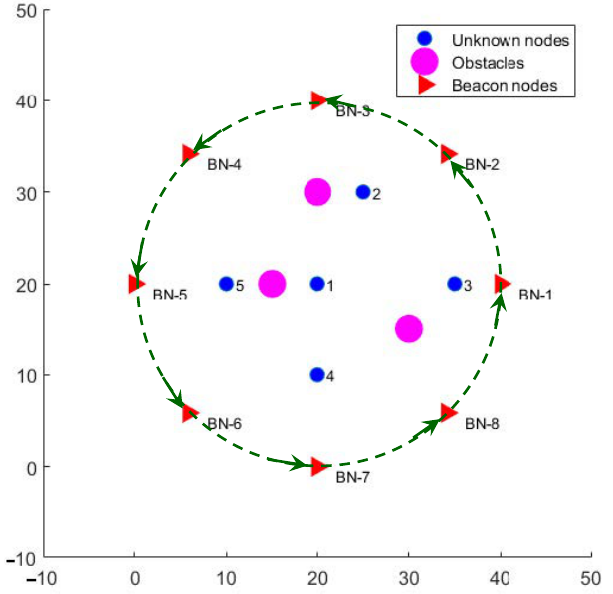
Figure 2. Assumed wireless sensor network model showing five unknown nodes (blue circles), eight beacon nodes (red triangles), and three obstacles (pink